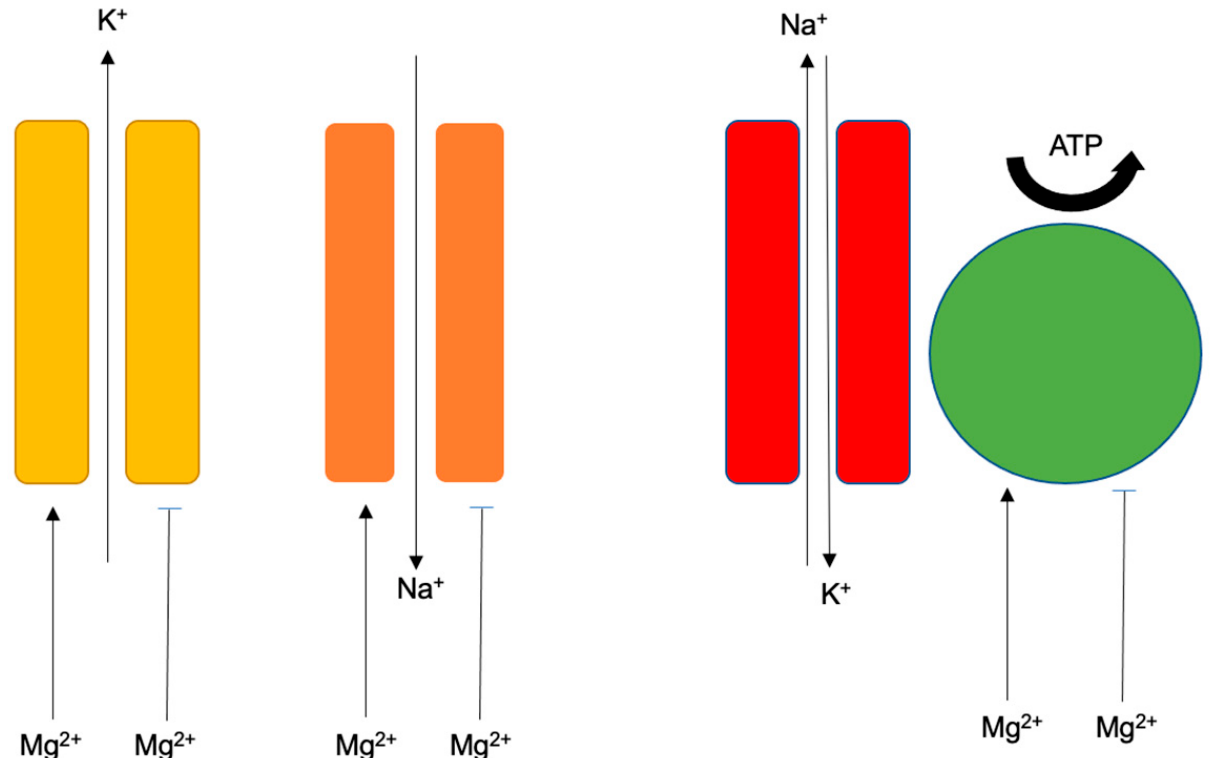
Figure 5. Effect of magnesium (Mg 2+ ) on potassium (K + ) channels, sodium (Na + ) channels, and sodium/potassium (Na + /K + ) ATPases transporting ions through cardiac myocytes.